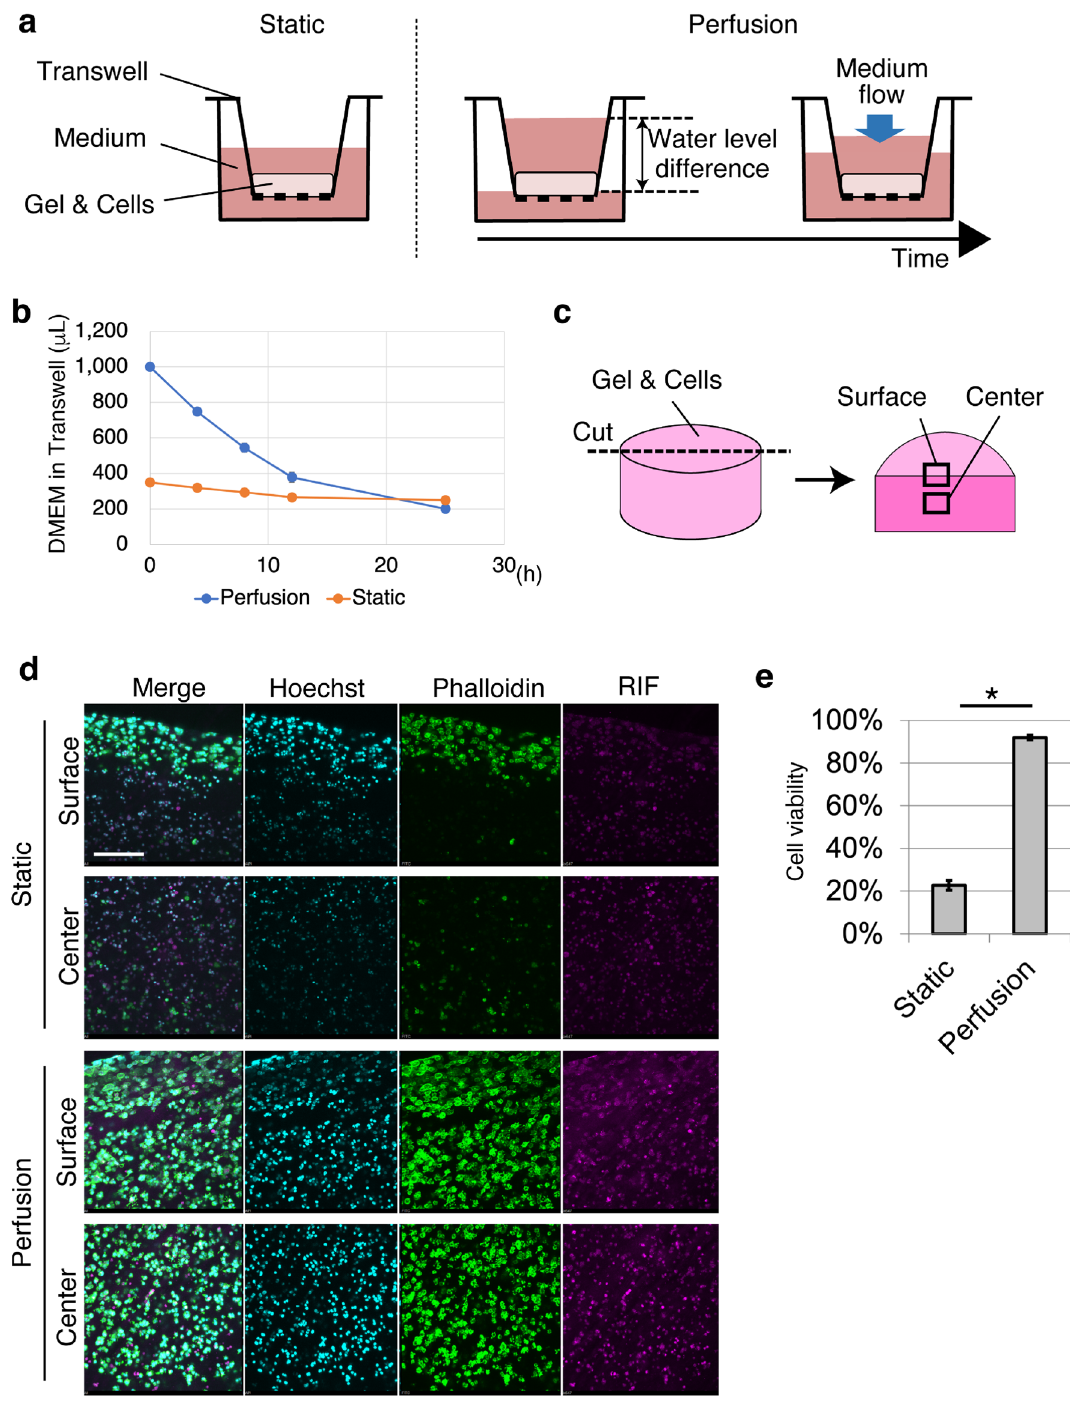
Figure 1. Cell viability improved with perfusion cell culture by water level difference (PCC-WLD). ( a ) Schematic of perfusion cell culture by water level difference (PCC-WLD) and control (static). ( b ) Flow rate of DMEM through the Transwell. n = 3 independent experiments. Mean ± S.E. ( c ) Schematic image of sample cutting. Dot line indicates where the samples were cut. Surface and central part of the cross section were observed. ( d ) Fluorescent images of the static and perfusion cell culture based on the live/dead cell assay. Cyan, Hoechst. Green, phalloidin Magenta, reflection interference (RIF). Scale bar, 200 μm. ( e ) The analysis of ( d ). n = at least 8 fields from 3 independent experiments. Mean ± S.E. *p < 0.0001 by Student’s t